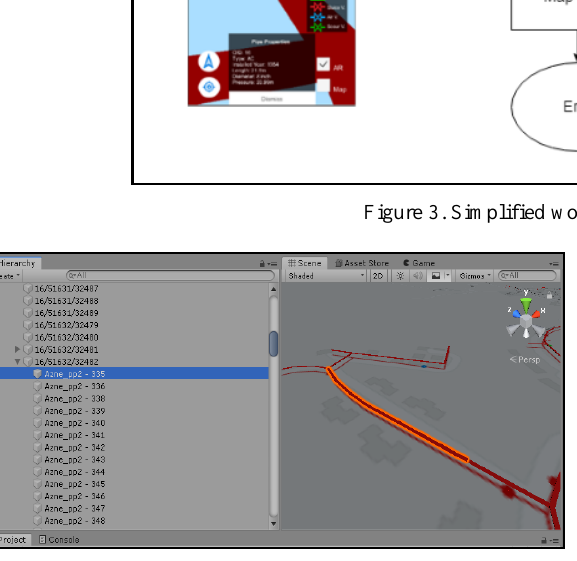
Figure 4. Game objects converted from GeoJSON in their respective location in Unity environment